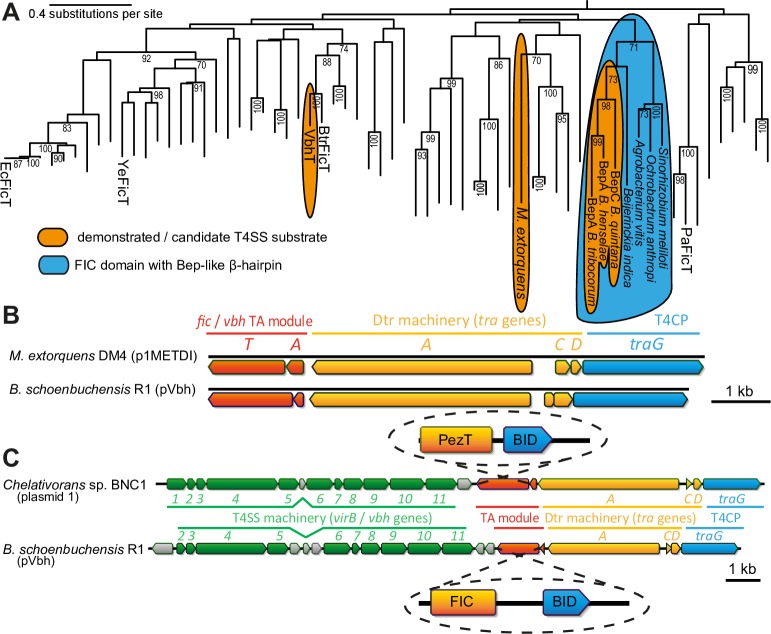
TA module toxins as bona fide substrates for conjugative type IV secretion.(A) The position of known and proposed T4SS substrates as well as proteins with a Bep-like β-hairpin are highlighted in the phylogeny of FicT toxins (adapted from our previous work [21]; see also S3A–S3C Fig). In short, the tree represents a maximum likelihood phylogeny that had been constructed from an alignment of the toxins’ FIC domains. An additional phylogeny supporting the repeated, independent recruitment of FicT toxins as T4SS substrates is presented in S3B Fig. FicT of M. extorquens (UniProt identifier C7CN81 (C7CN81_METED)) is shown as a candidate T4SS substrate because it carries a BID-like sequence at its C-terminus (S3C Fig). (B) The genetic arrangement of vbhAT at the Dtr locus of pVbh of B. schoenbuchensis R1 was compared to the locus encoding the FicTA module on p1METDI of M. extorquens DM4 (genbank accession number NC_012987). (C) The illustration shows how a PezTA module on Chelativorans sp. BNC1 plasmid 1 (genbank accession number CP000389.1) is encoded between the conjugative VirB T4SS and its Dtr machinery in the same genetic arrangement as the VbhTA module is encoded on pVbh.